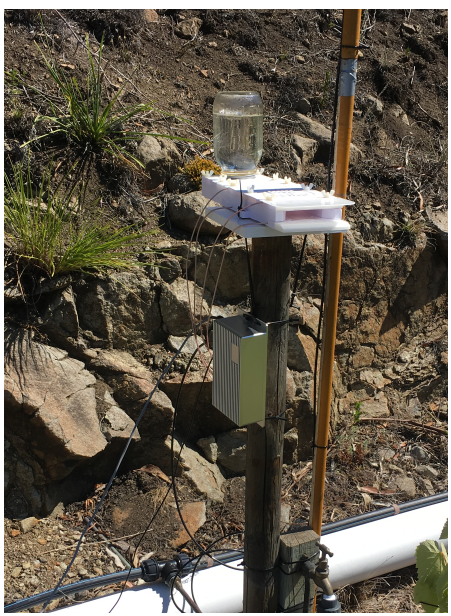
Figure 5. Feeder station equipped with the presented system.